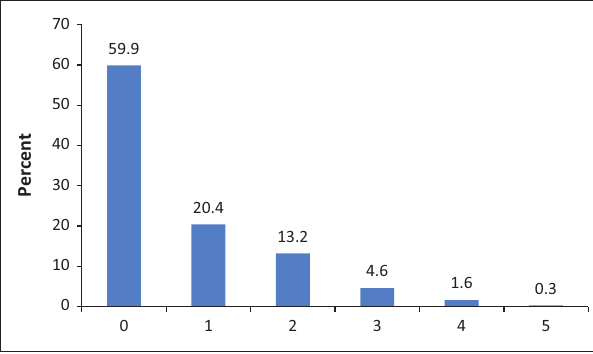
FIGURE 1: Number of screenings carried